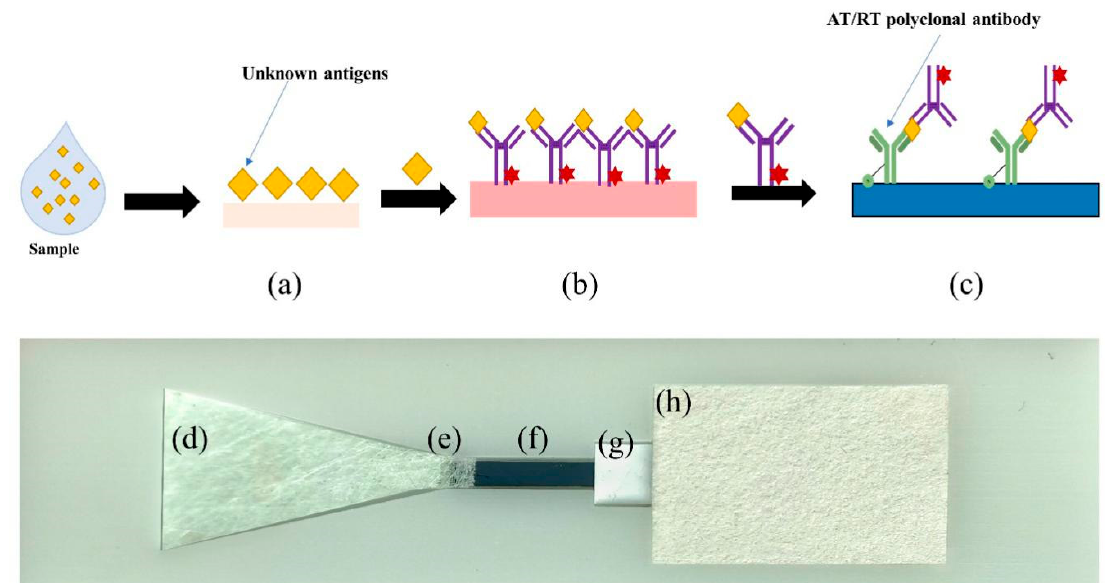
Figure 7. Physical assembly and flow process of the microfluidic chip sensors. ( a , d ) Sample pad. ( b , e ) Conjugate pad. ( c , f ) Detection area containing the corresponding capture antibody with nanofor- est. ( g ) Speed-limiting membrane. ( h ) Absorbent